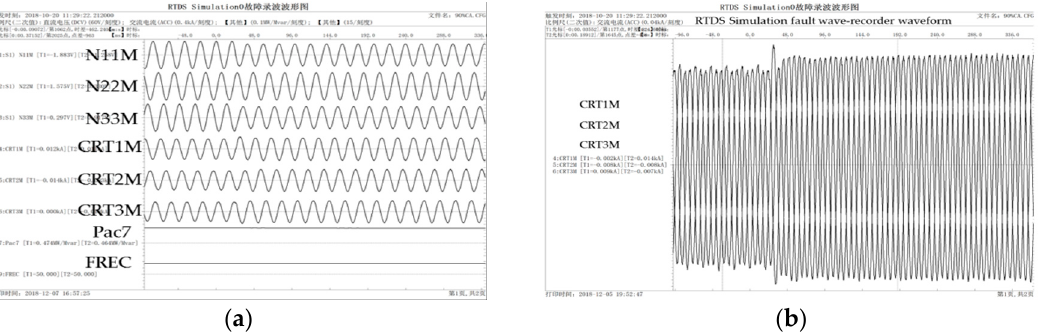
Figure 17. ( a ) Wave-recorder graph of the low-voltage ride through (LVRT) experiment. ( b ) Wave-recorder graph of three-phase output current.